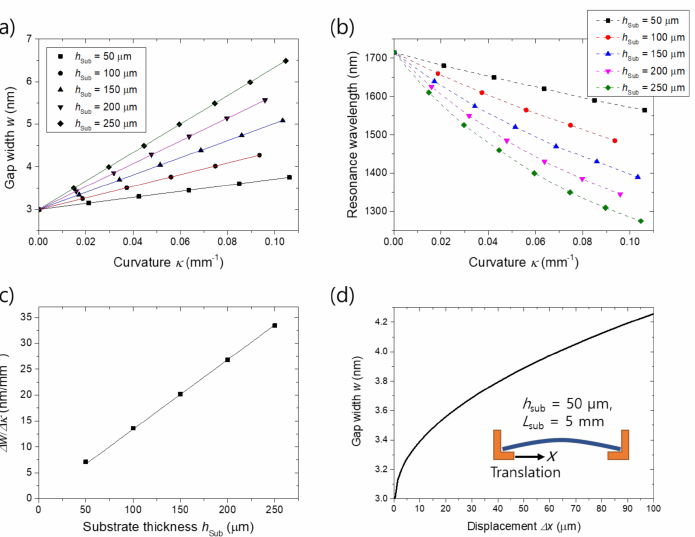
Figure 5. Effect of the substrate thickness on the active width control: ( a ) Gap width versus substrate curvature for PDMS substrate thicknesses h sub of 50, 100, 150, 200 and 250 µ m; ( b ) Resonance wavelength as a function of the curvature for the various PDMS thickness; ( c ) ∆ w / ∆ κ , the slope in ( a ) versus substrate thickness; ( d ) Gap width versus displacement of the supporting stage for the case of h sub = 50 µ m when the substrate length is 5 mm. Bending is assumed to be realized by translating a supporting stage as illustrated in the inset. Solid lines in ( a , c ) are linear